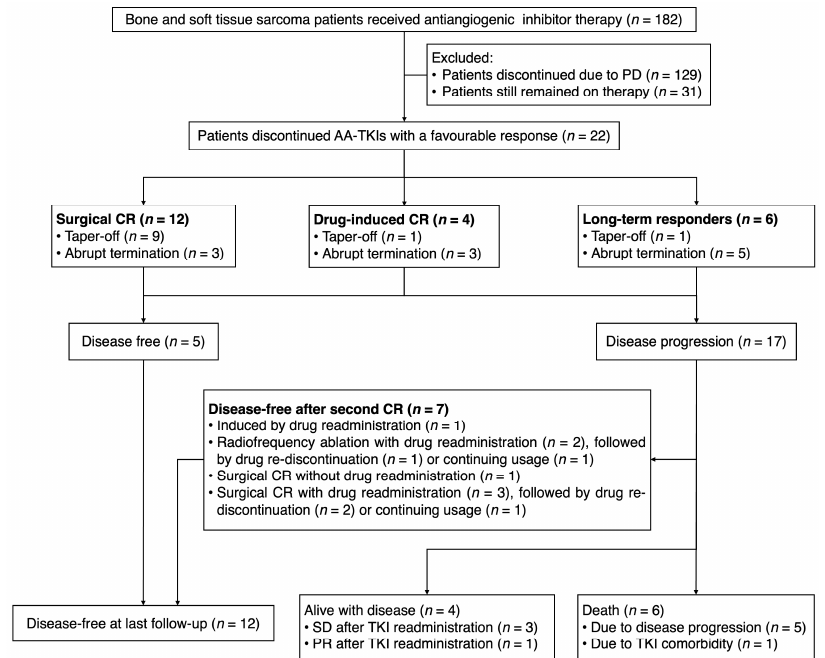
Figure 1. Consort flow diagram of our study. Long-term responders were defined as having a duration of response of > 6 months. PD = disease progression. CR = complete response. PR = partial response. SD = stable disease. Table 1. Clinical characteristics of 22 patients before the AA-TKI discontinuation. No.